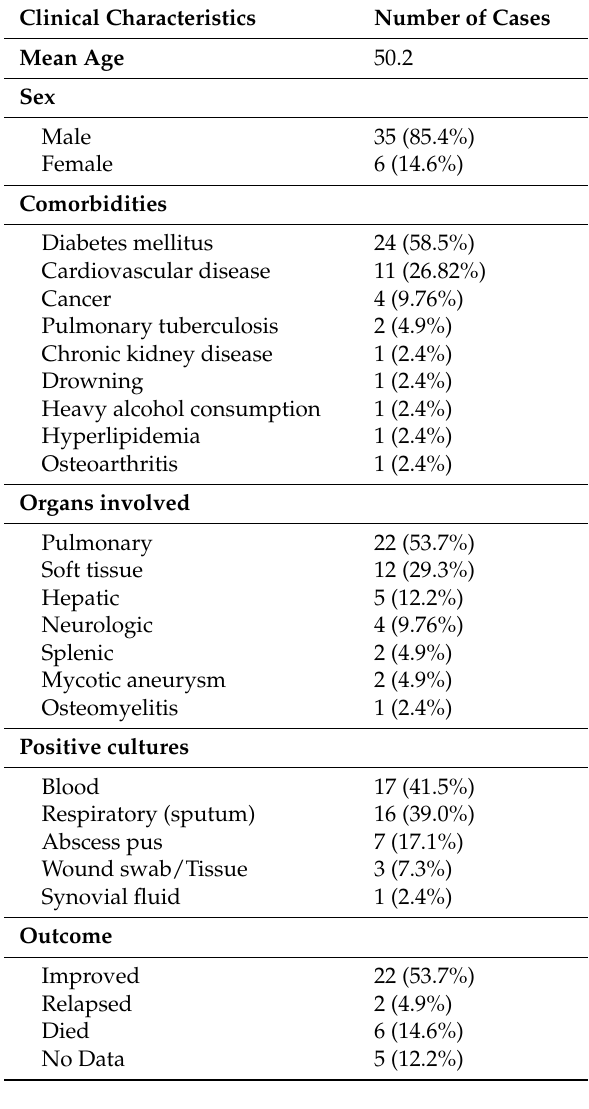
Table 3. Summary of clinical characteristics of culture-confirmed cases of melioidosis in the